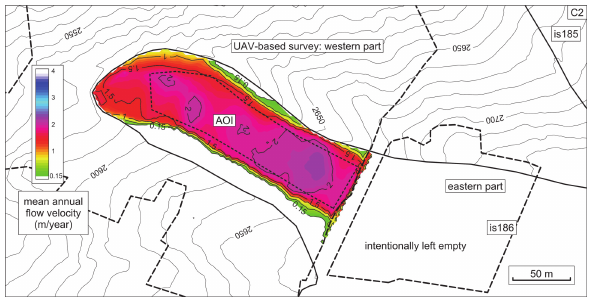
Figure 9. Mean annual horizontal flow velocity 2016-2017